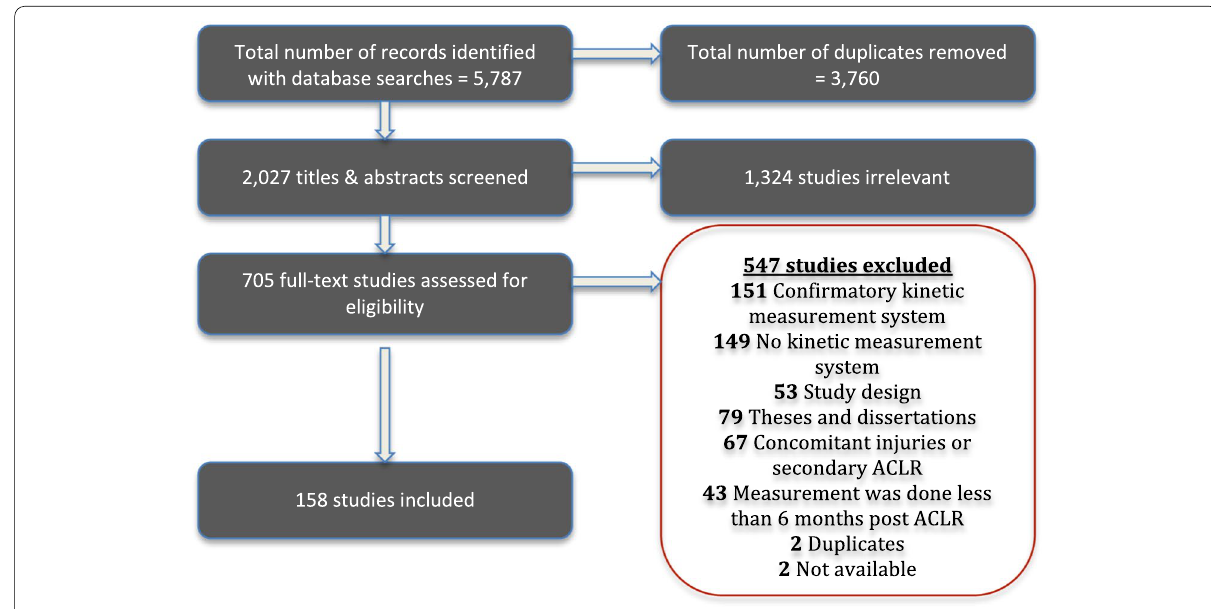
Fig. 1 Search Results and Study